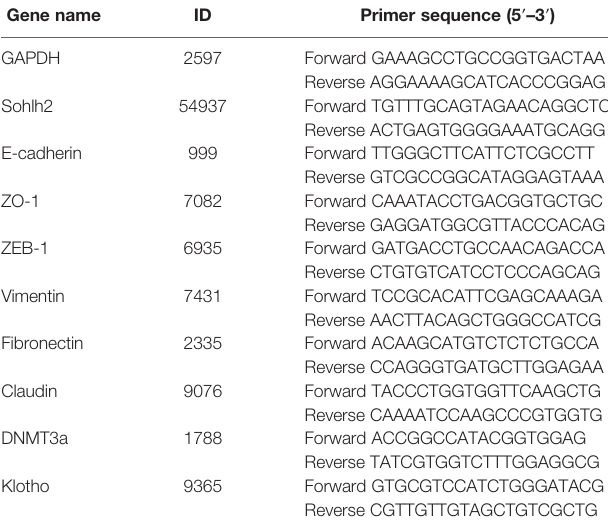
TABLE 1 | The sequences of qPCR